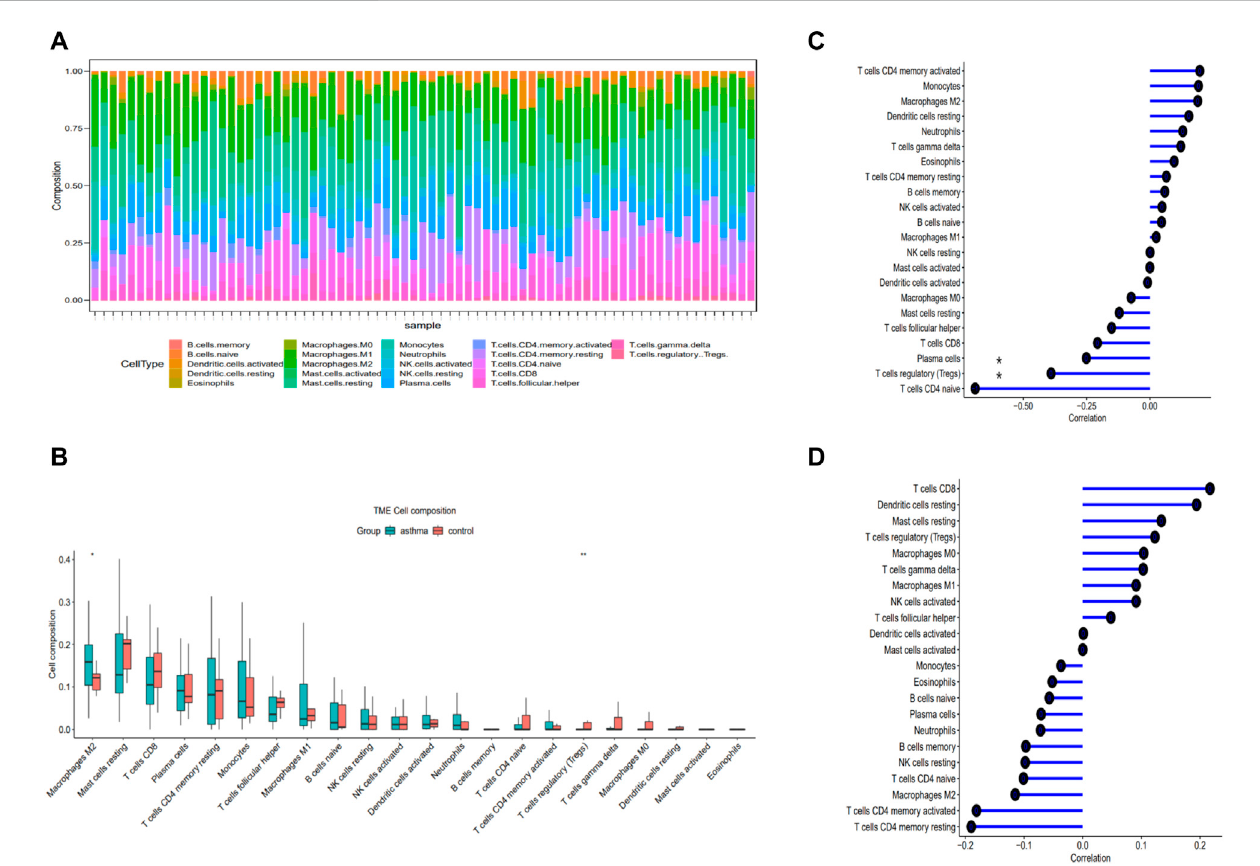
FIGURE 4 Evaluation of immune cell in fi ltration and correlational analysis. (A) Barplot shows the proportion of 22 types of immune cells in asthma. (B) The identi fi cation of differentially in fi ltrating immune cells (C) The correlation analysis of CISD1 and immune cells. (D) The correlation analysis of CAMKK2 and immune